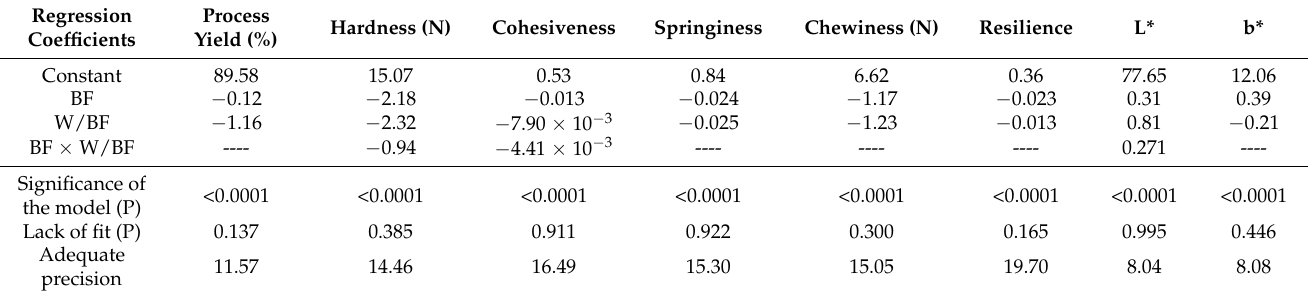
Table 2. Regression coefficients of the proposed model for the variables: process yield, texture variables (hardness, cohesiveness, springiness, chewiness, resilience), and color parameters (L* and b*) expressed in terms of the coded level of the bean flour (BF) and water/bean flour ratio (W/BF) in the BF-burgers. Statistical significance of the models (P), lack of fit, and “adequate precision” coefficient, are also